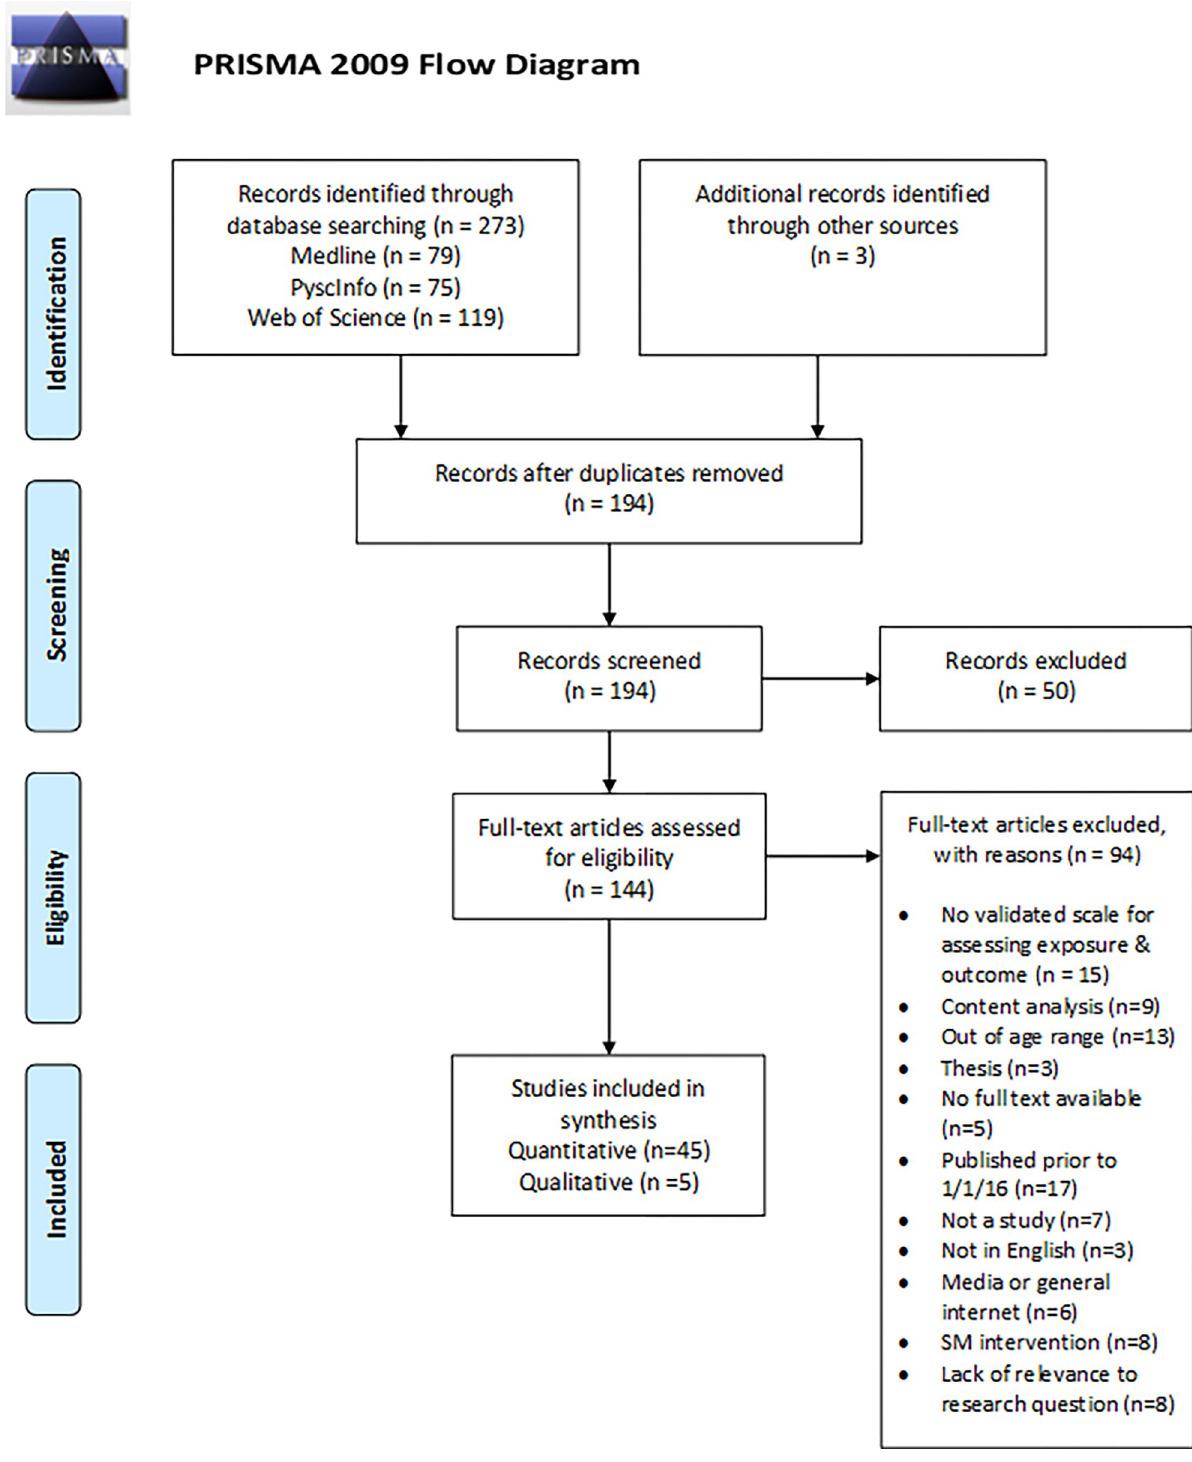
Fig 1. PRISMA flow